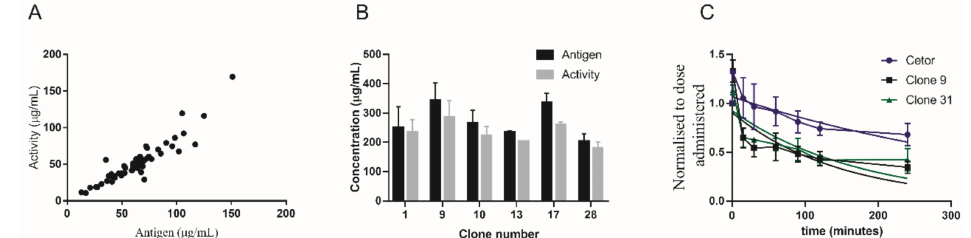
Figure 1. Production levels of recombinant C1-inhibitor (rC1-INH) and half-life in vivo. ( A ) Antigen and activity levels of C1-INH produced by 57 different Chinese hamster ovary (CHO) cell clones. Antigen and activity levels correlate with a correlation efficiency of r = 0.962 p < 0.001 (Pearson two-tailed analysis). ( B ) Antigen and activity levels of rC1-INH in culture supernatants of the highest producing C1-INH clones after upscaling. ( C ) In vivo half-life of plasma-derived C1-INH (pdC1-INH) (Cetor) ( n = 2), rC1-INH isolated from CHO clone 9 ( n = 6) and rC1-INH isolated from CHO clone 17 ( n =